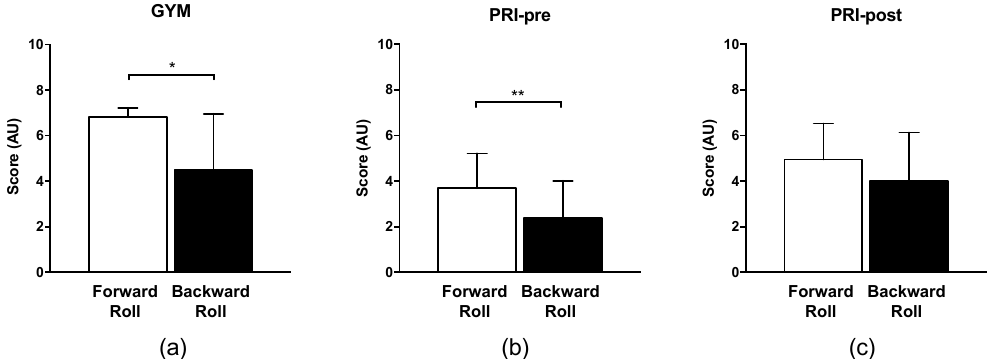
Figure 1. Comparisons between forward and backward rolling in GYM ( a ) PRI pre-training ( b ) and PRI post-training ( c ). PRI = primary school children; GYM = gymnasts. * = p < 0.05; ** = p < 0.01.